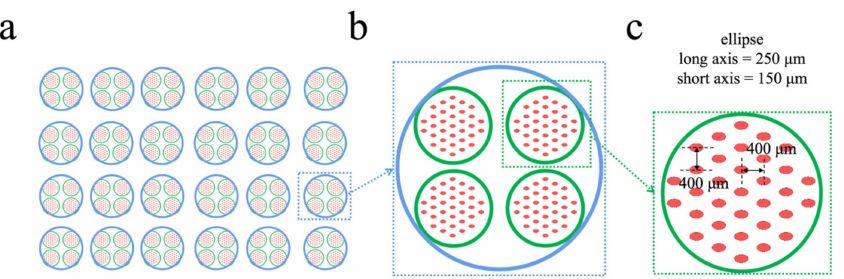
Figure 1. Design of the 3D cell culture device ( a ) overall design; ( b ) a top view of a large reservoir of the same size as the wells of a 96-well plate; ( c ) a top view of a small reservoir of the same size as the wells of a 384-well